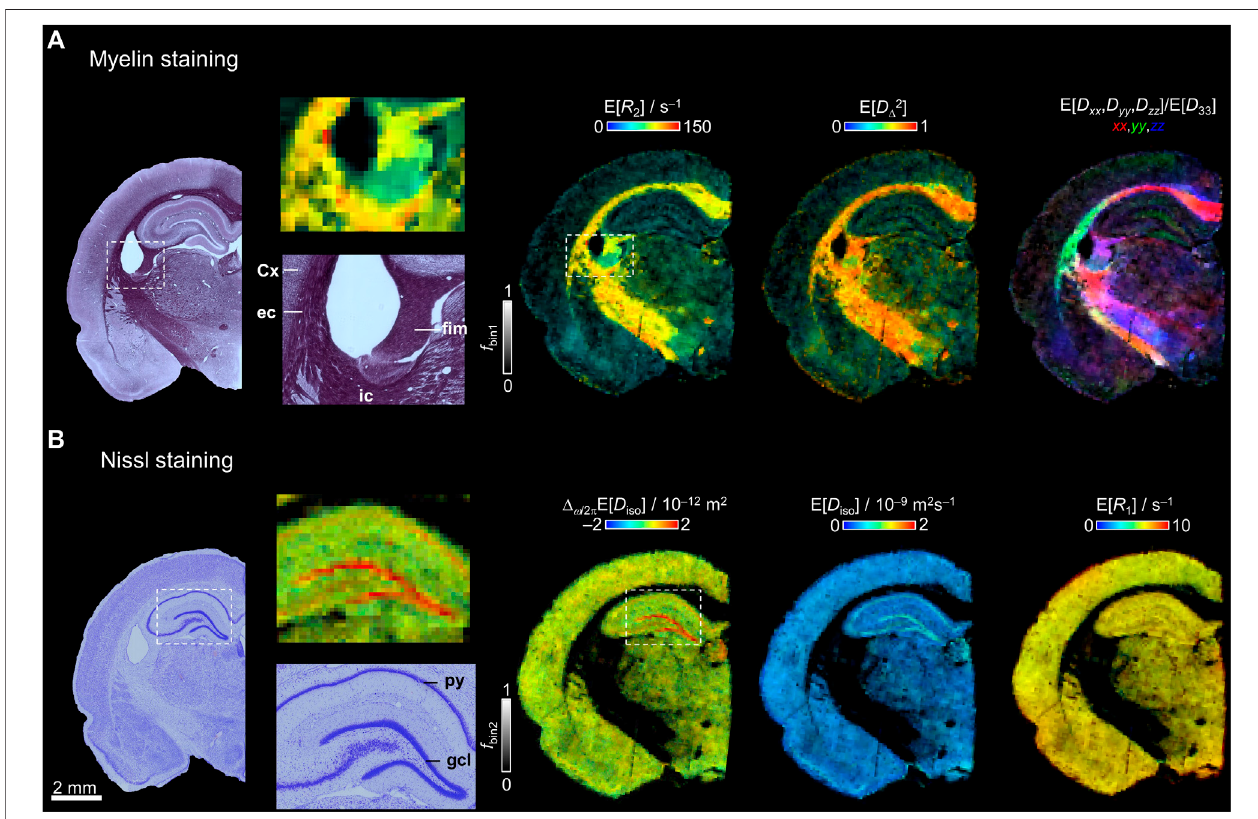
FIGURE 5 | Comparison between histology and selected parameter maps. (A) Myelin-stained section and bin1-resolved E[ R 2 ], E[ D Δ 2 ], and E[ D xx ,D yy ,D zz ]/ E[ D 33 ] maps with brightness and color-coding as in Figure 3D . The darker intensities in the myelin staining correspond to the main white matter tracts and the lighter regions have lower density of myelin. A closer view to the myelin staining and E[ R 2 ] is displayed showing the fi mbria ( fi m), cortex (Cx), external capsule (ec), and internal capsule (ic). (B) Nissl-stained section and bin2-resolved Δ ω /2 π E[ D iso ], E[ D iso ], and E[ R 1 ] maps. A closer view of the hippocampus and dentate gyrus in the Nissl staining and the Δ ω /2 π E[ D iso ] map displays the granule cell layer (gcl) and pyramidal cell layer